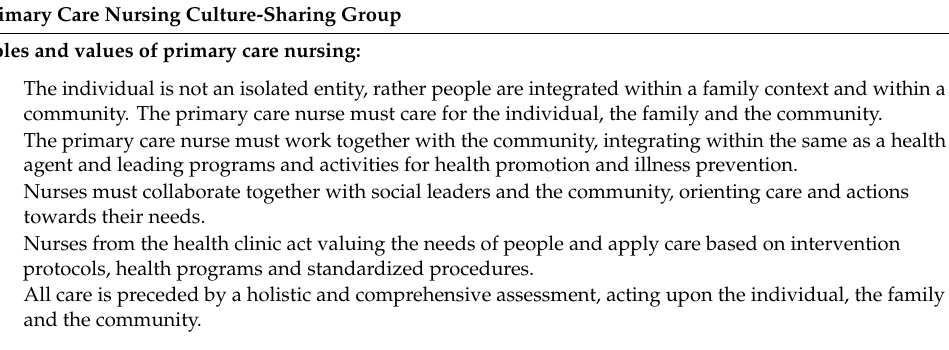
Table 2. Primary care nursing culture-sharing